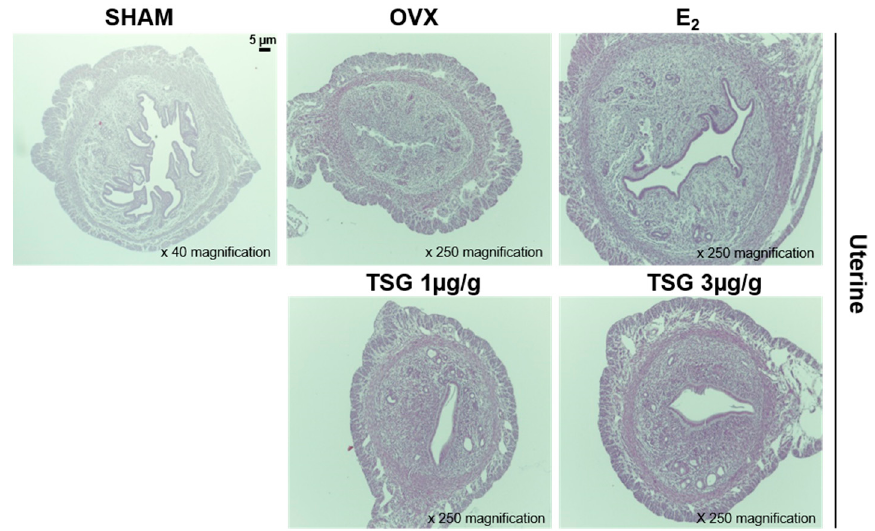
Figure 8. Effect of TSG on the trabecular bone tissue in the proximal tibia of C3H/HeN mice. Mice were treated with vehicle and TSG (1 and 3 μ g/g/day, I.P.) for six weeks. ( A ) Histological analysis of the proximal tibia with hematoxylin and eosin (H and E) and tartrate-resistant acid phosphatase (TRAP), Masson’s trichrome staining (400× magnification); ( B ) trabecular bone area; ( C ) TRAP positive cell and ( D ) collagen in tibia were analyzed by the Image J program. a, b, c, d, and e: The means not sharing a common letter are significantly different among groups at p < 0.05 by one-way ANOVA with Duncan’s multiple-range test.